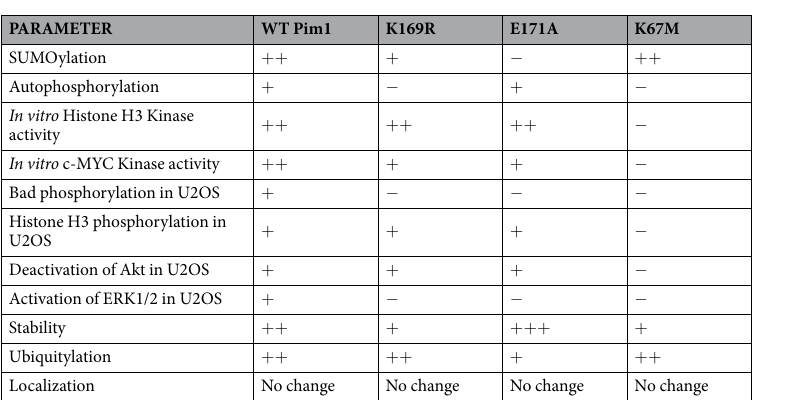
Table 1. SUMOylation status and functional characteristics of PIM1